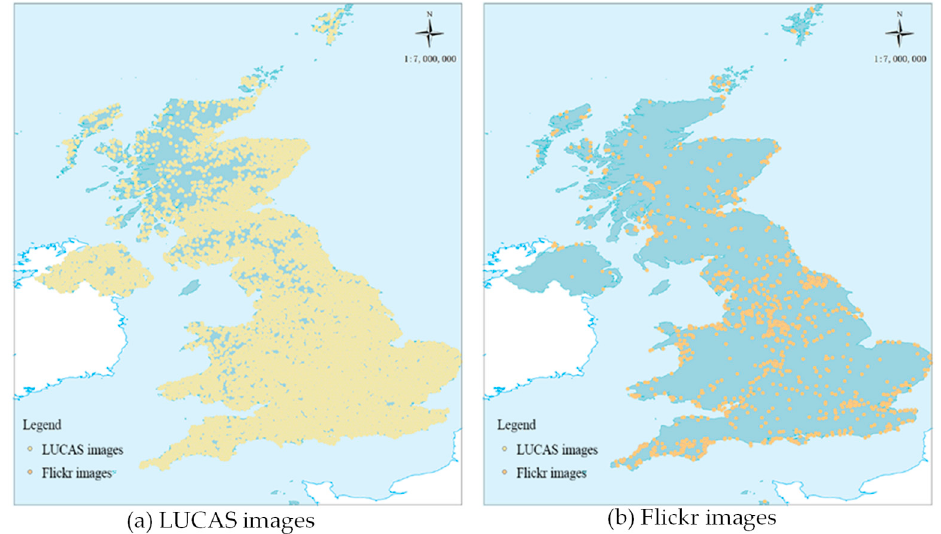
Figure 4. Spatial distribution of images from LUCAS and Flickr in UK (verification area). ( a ) LUCAS images, ( b ) Flickr images.